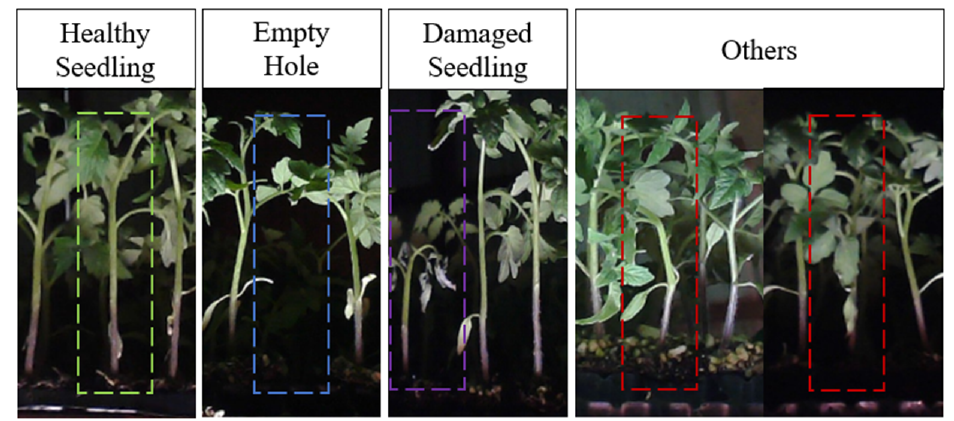
Figure 8. Four types of characteristics.